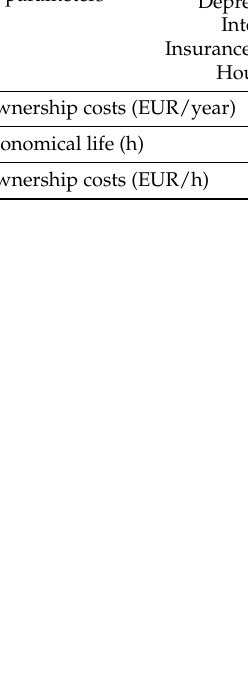
Table 5. The calculation of ownership costs for robotic and conventional machinery in weeding